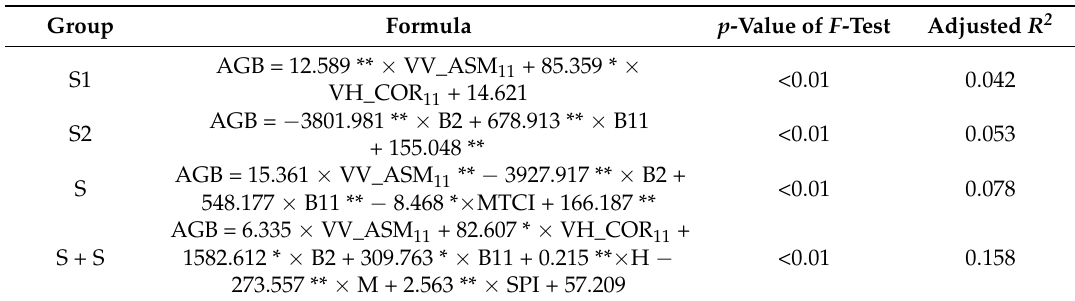
Table 4. Summary of AGB models by